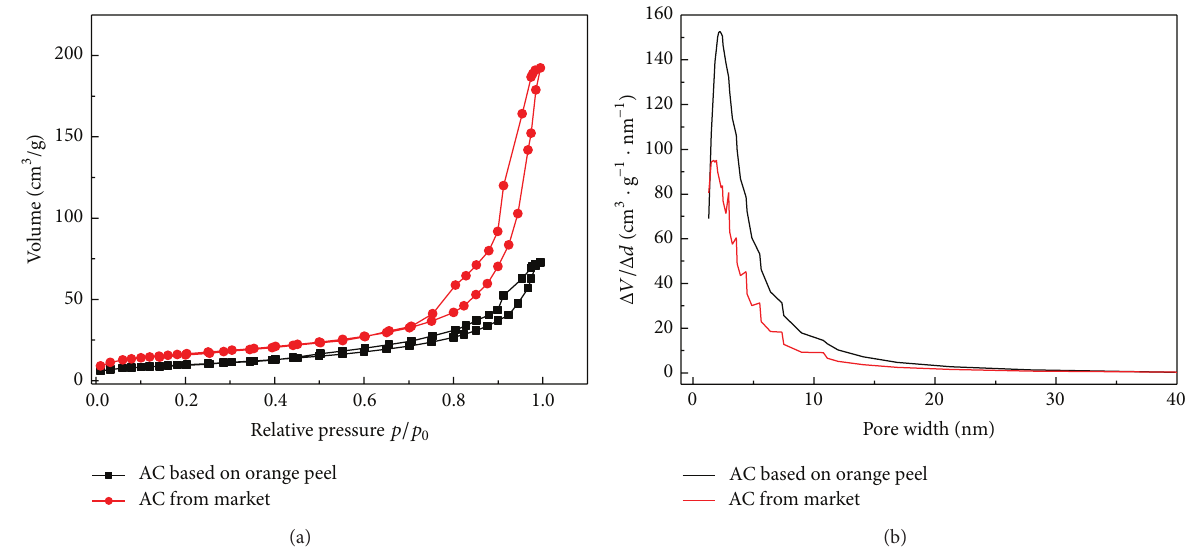
Figure 5: N 2 adsorption-desorption isotherms (a) and pore-size distribution curves (b) of citrus peel mesoporous active carbon and commercial active carbon.